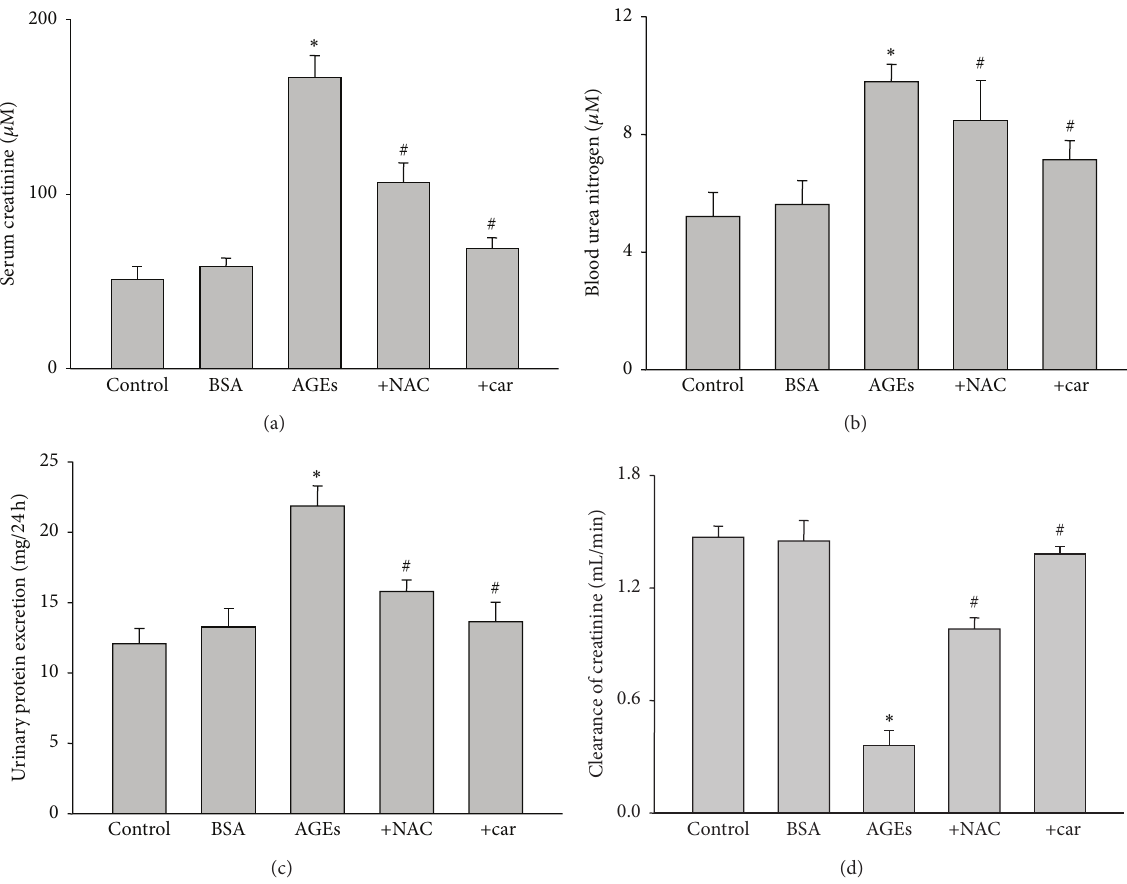
Figure 4: In vivo administration of cariporide prevents renal dysfunction in AGEs-injected rats. The rats received a tail vein injection of AGEs (100mg/kg) followed by treatment with or without N-acetylcysteine (200 mg/kg/day) or cariporide (1mg/kg/day) for 12 weeks. At the end of experiments, (a) serum creatinine level, (b) blood urea nitrogen, (c) urinary protein excretion, and (d) clearance of creatinine were measured, respectively. All data were expressed as mean ± SD. 𝑁 is 5 in each group. ∗ 𝑃 < 0.05 versus BSA. # 𝑃 < 0.05 versus AGEs alone.